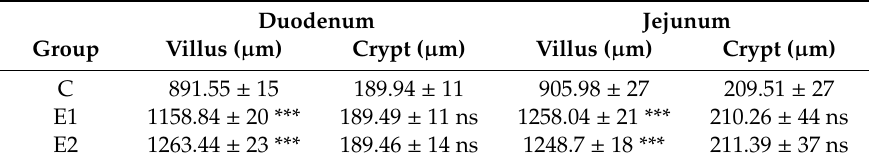
C group: basal diet / control group; E1 group: basal diet with 0.5% bilberry leaves and E2 group: basal diet with 1% walnut leaves. All data are reported as mean values ± standard deviation (SD) and statistical significance, where ns p > 0.05, *** p ≤ 0.001; (n = 10); n: number of